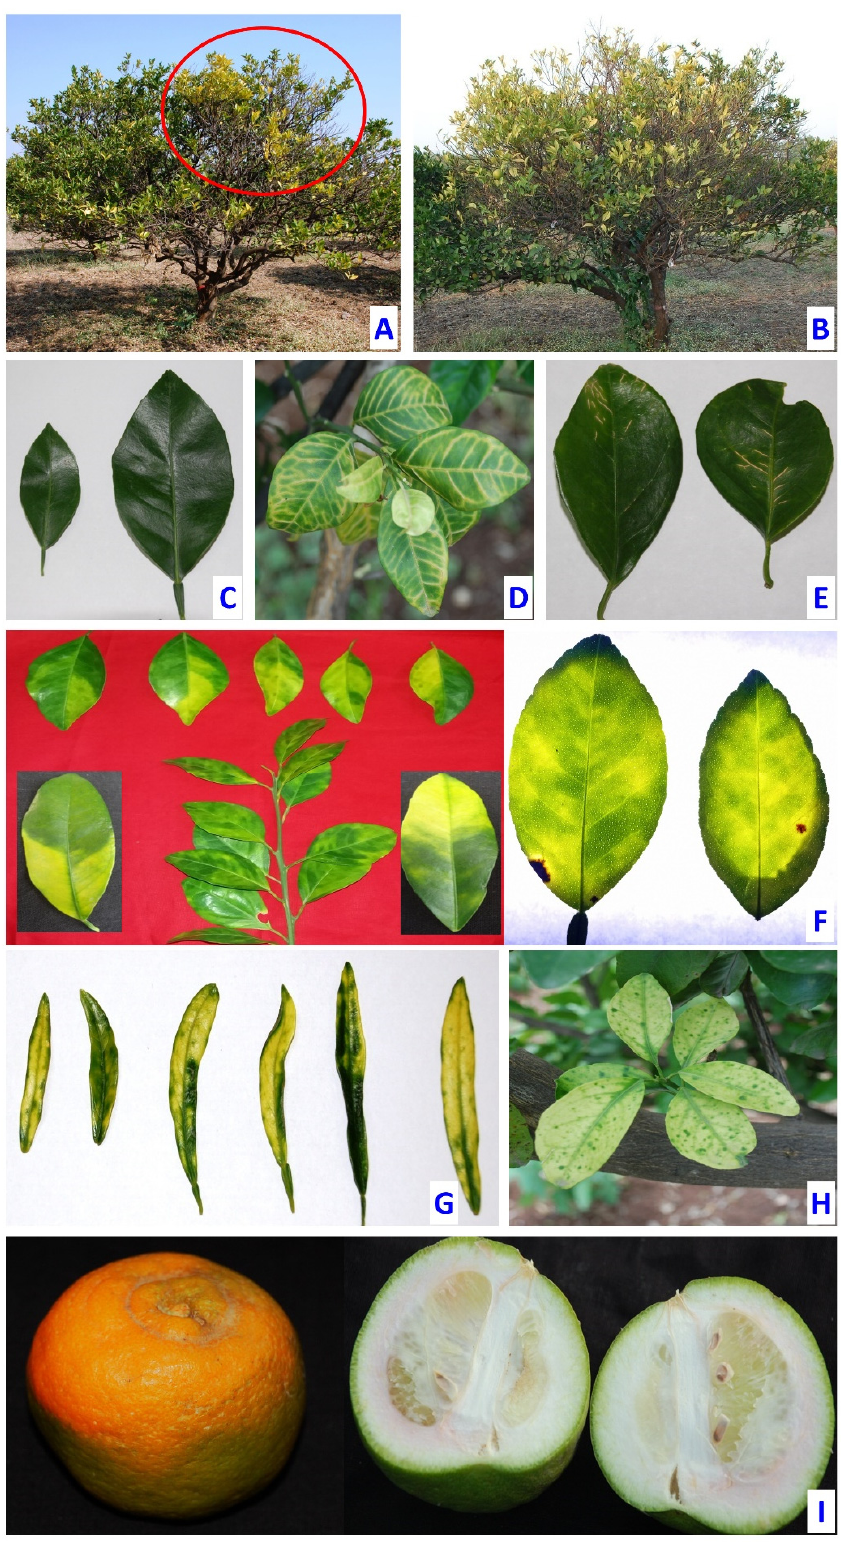
Figure 2. ( A ) HLB-infected sweet orange plant in the field showing characteristic yellow shoot symptoms at initial stage. ( B ) HLB-infected sweet orange in the field at severe stage. ( C ) Healthy leaf. ( D ) Vein yellowing and corking. ( E ) Vein corking. ( F ) Blotchy mottle (a random pattern of chlorosis). ( G ) Narrow leaf with blotchy mottle. ( H ) Green island. ( I ) HLB-affected with color inversion and misshapen sweet orange fruit (lopsided) with aborted seeds.